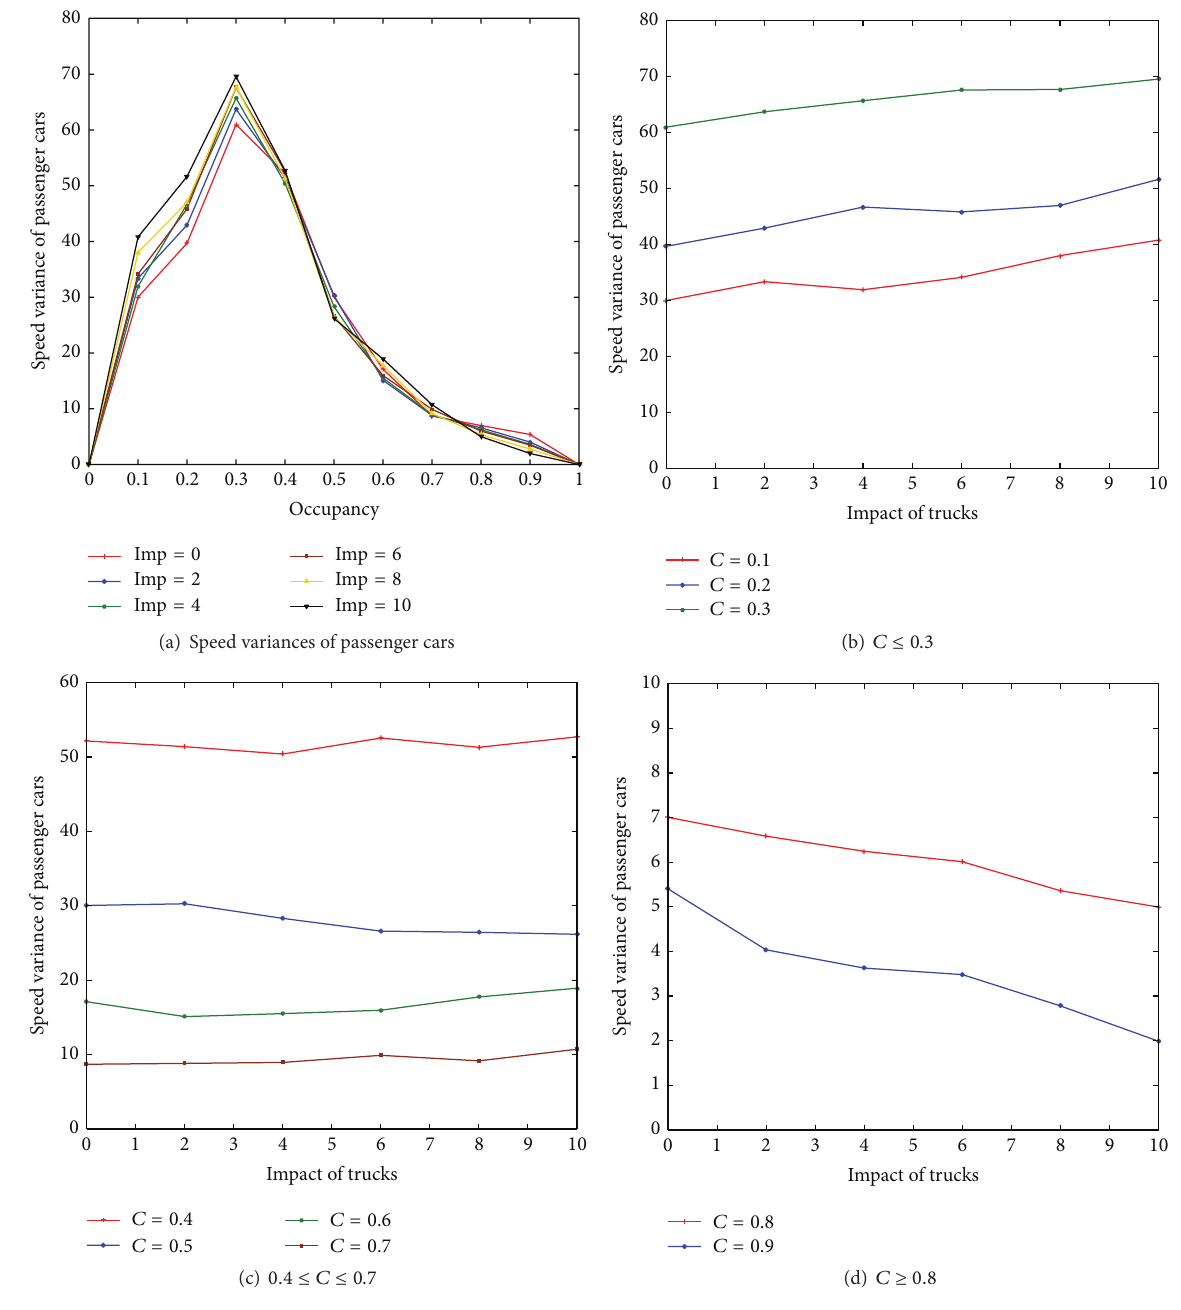
Figure 6: Speed variances of passenger cars when 𝑟 = 0.2